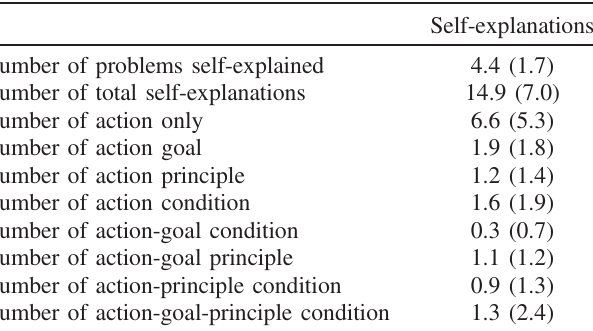
TABLE III. The mean number (SD) of different self-explanation categories. Note that n ¼ 18